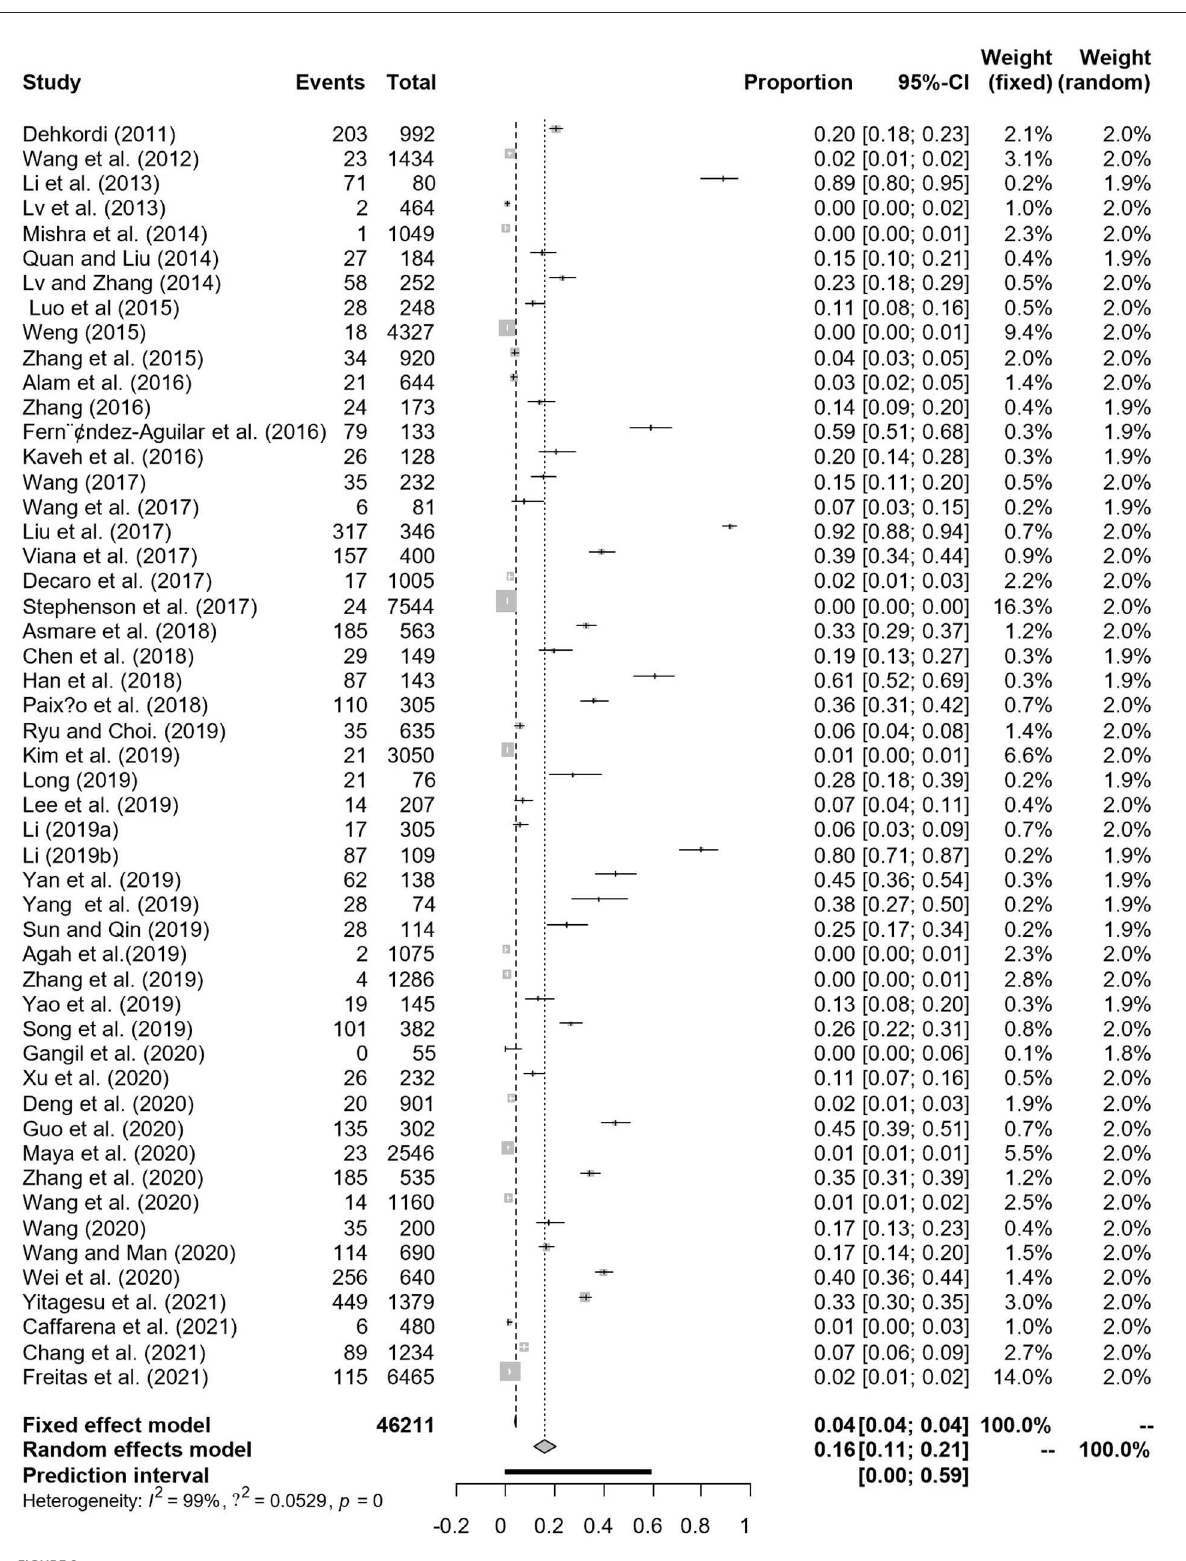
FIGURE2 Forest plot of bovine viral diarrhea virus antigen prevalence in the world study conducted 2010–2021 (decetion